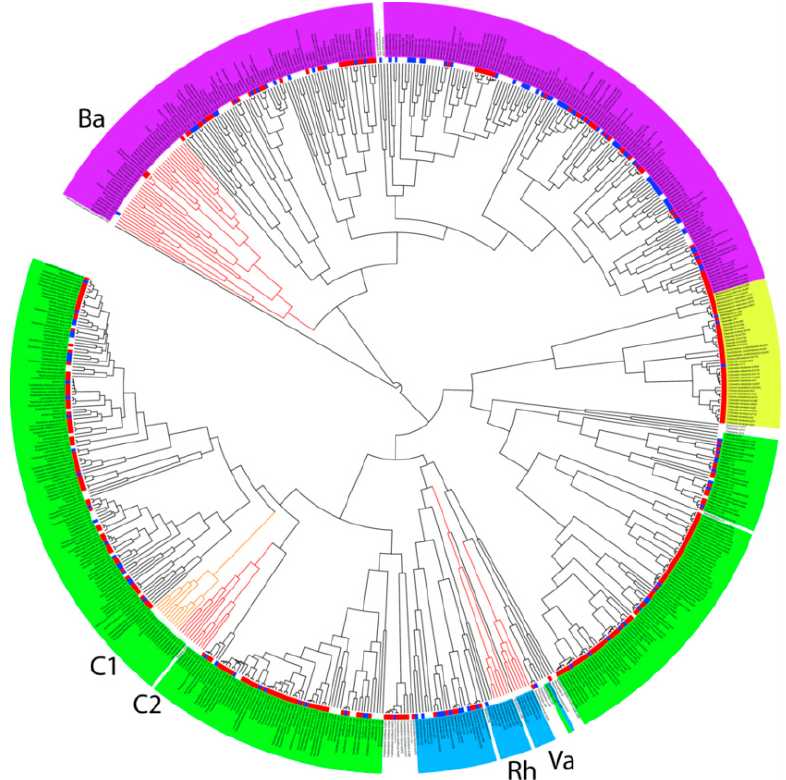
Figure 2. Taxonomic classification of the most common bacterial isolates colonising the chicken caecum and their ability to grow in vitro. Magenta background— Bacteroidetes , blue— Proteobacteria , yellow— Actinobacteria , and green— Firmicutes . Blue squares external to the dendrogram indicate the ability to grow in vitro using different culture conditions. Red squares indicate isolates which we obtained in pure cultures in our previous experiments, i.e., which can be grown in vitro. Lineages difficult to culture in vitro are highlighted by red or orange branches. Ba— Bacteroidetes lineage, C1 and C2—two different lineages of Clostridiales , Rh— Rhodospirillaceae , Va— Vampirivibrio . See Figure S1 to zoom in.